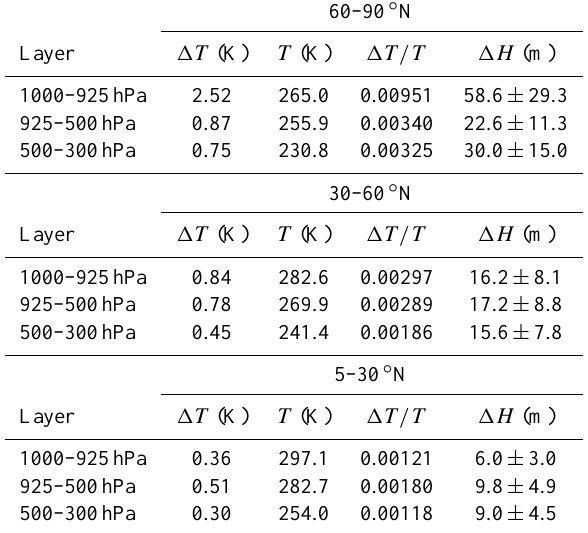
Table 1. Layer-mean air temperatures ( T ), changes in air temper- atures ( (cid:49)T over 30 years), ratios ( (cid:49)T/T ) and changes in scale height of water vapour ( (cid:49)H ) at three latitudinal belts: 60–90, 30– 60 and 5–30 ◦ N. The data of T and (cid:49)T were provided by the study of Zerefos et al. (2014) and refer to the period 1980–2011. The (cid:49)T were calculated from NCEP reanalysis and filtered from nat- ural